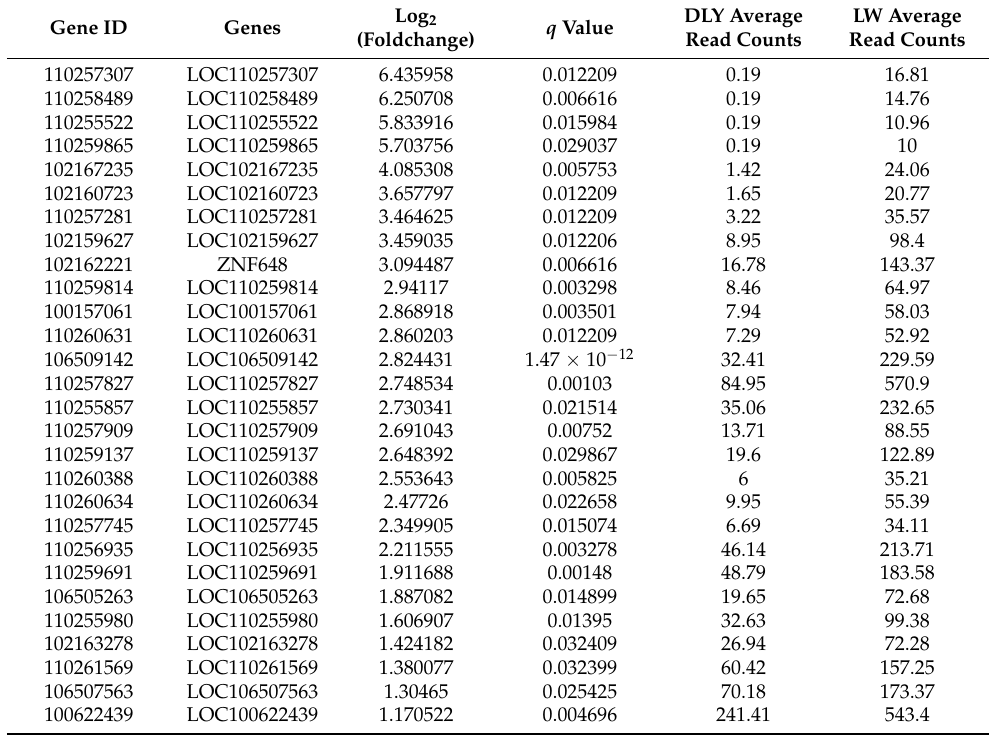
Table 7. The upregulated lncRNAs in the Longissimus dorsi muscle sample of LW pigs.